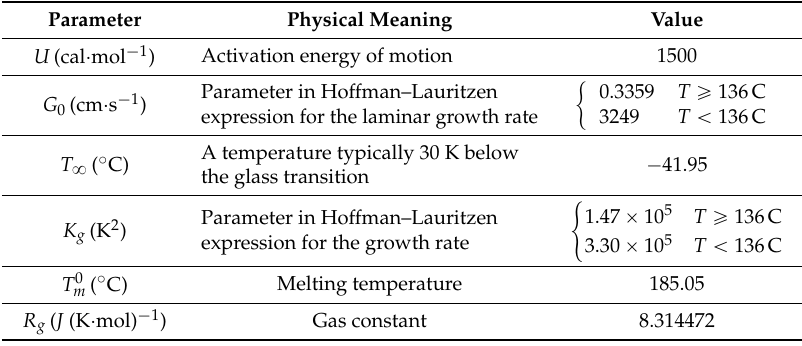
Table 1. Numerical values for the parameters of iPP used in the models.